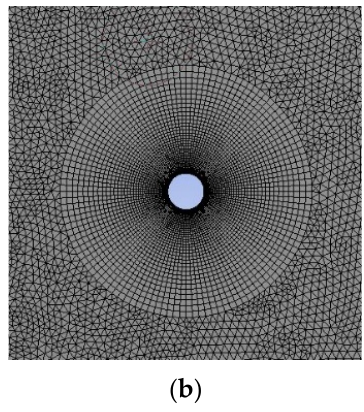
Figure 3. ( a ) Mesh ( b ) Mesh closeup view near cylinder.